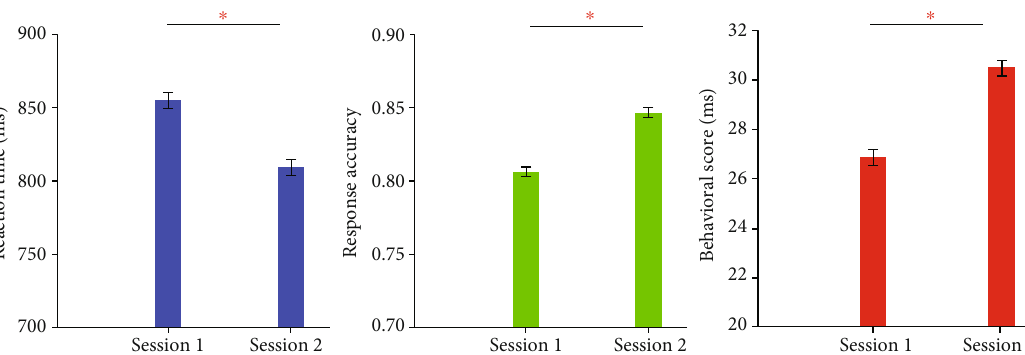
Figure 2: Behavioral analysis before and after WM training. Session 1: before training. Session 2: after training. Red star means signi fi cance ( p < 0 : 05